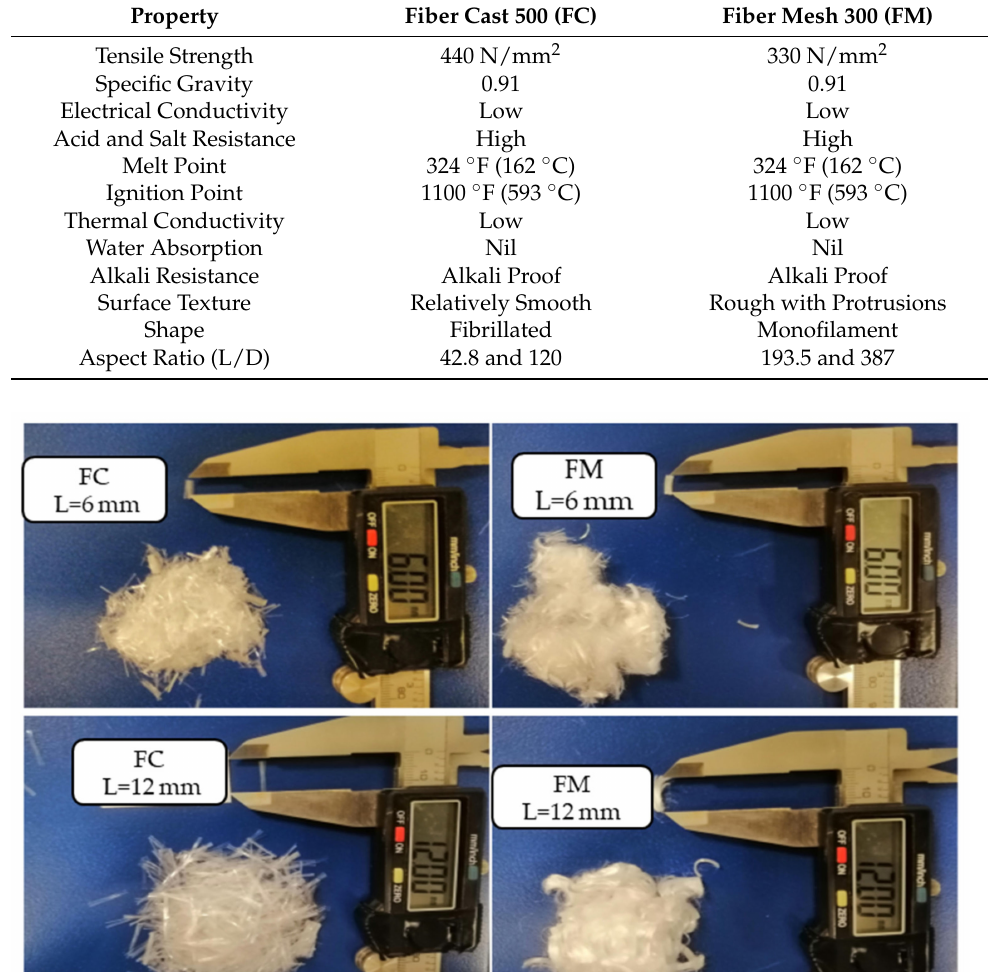
Table 2. Physicochemical properties of fibers.